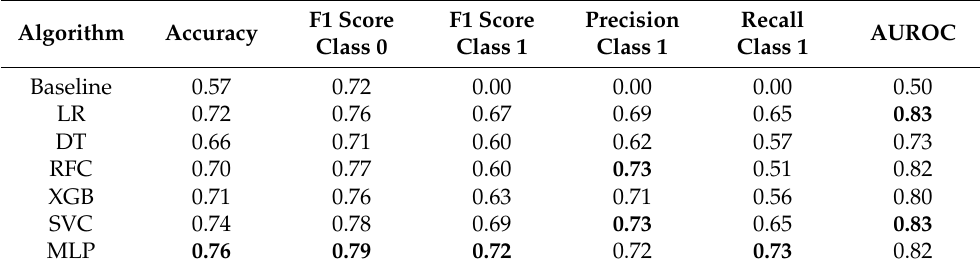
Table 3. Performance metrics on the test